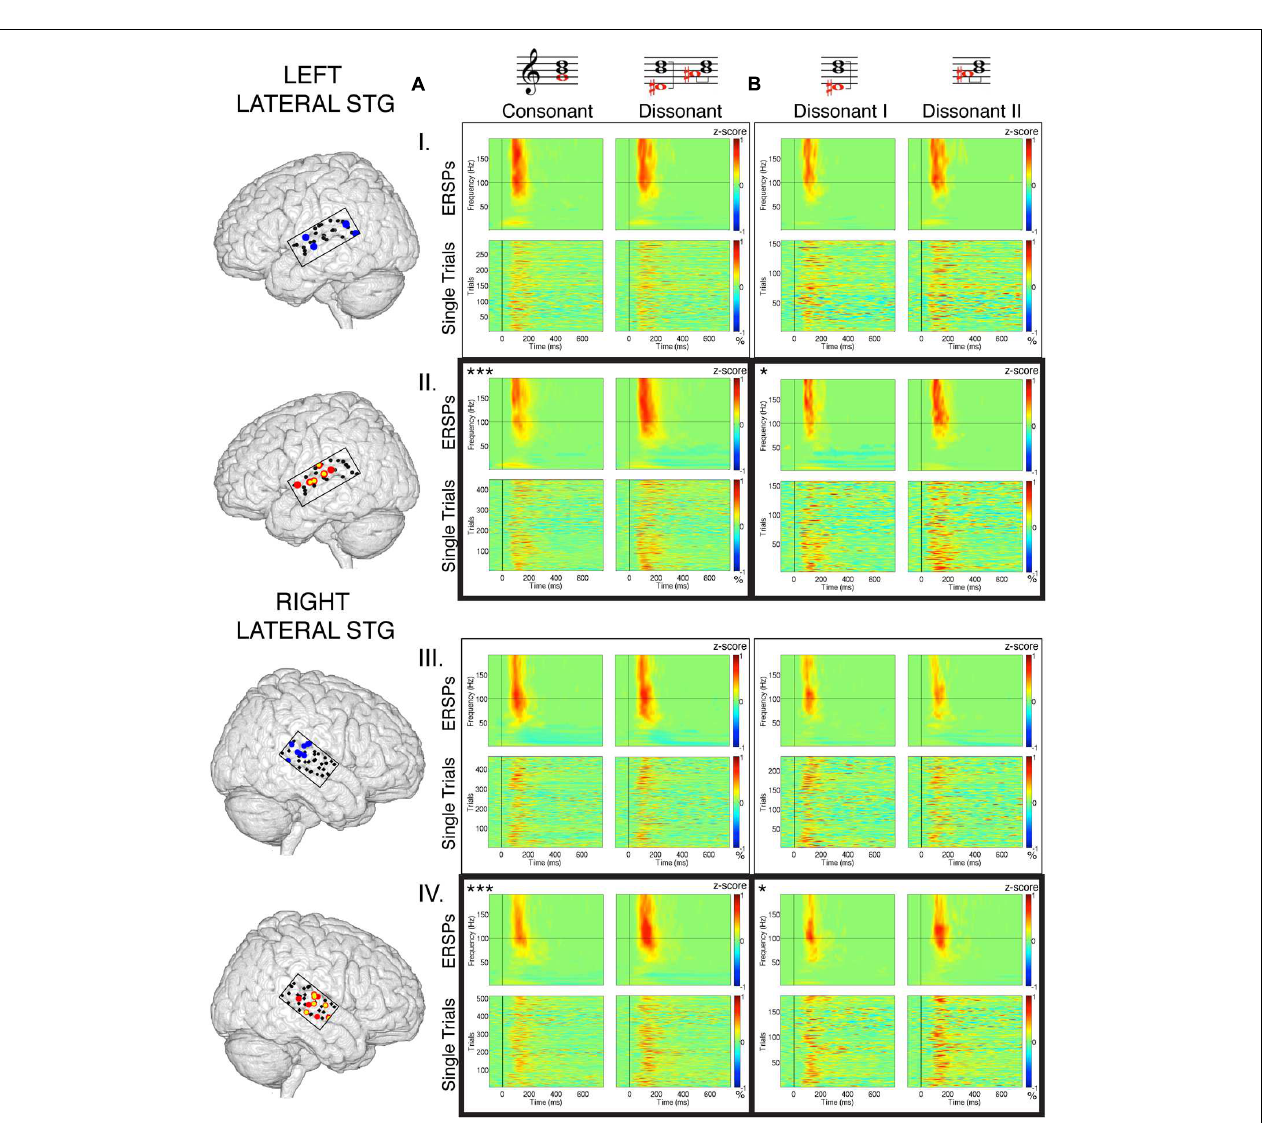
FIGURE 3 | Averaged ERSPs and Single Trial γ high responses to consonant vs. dissonant chords (A) and dissonant I vs. dissonant II chords (B) for electrodes denoted in blue (I) and red (II) in the left hemisphere, and electrodes denoted in blue (III) and red (IV) in the right hemisphere. ERSPs and single trial responses are shown between − 100 and 750 ms of stimulus onset. ERSPs are expressed in terms of a z -score normalized between − 1 and 1 across all subjects. Single trial responses are expressed in terms of the % change in γ high activity compared to baseline activity ( − 200 to 0 ms pre-stimulus onset) normalized between − 1 and 1 across all subjects. Number of electrodes per group: IA, IB, IIB – 4; IIA, IVB – 6; IIIA, IIIB – 8; IVA – 10. Averaged ERSPs showing increased γ high activity between 75 and 200 ms post-stimulus onset for dissonant chords compared to consonant chords as well as for dissonant type II chords compared to dissonant type I chords are boxed. ∗ p < 0.05, ∗∗∗ p < 0.001 (Wilcoxon rank-sum).